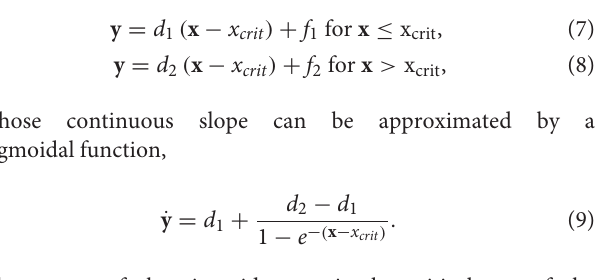
3) A sigmoidal non-linear function of age (see Figures 1 – 3